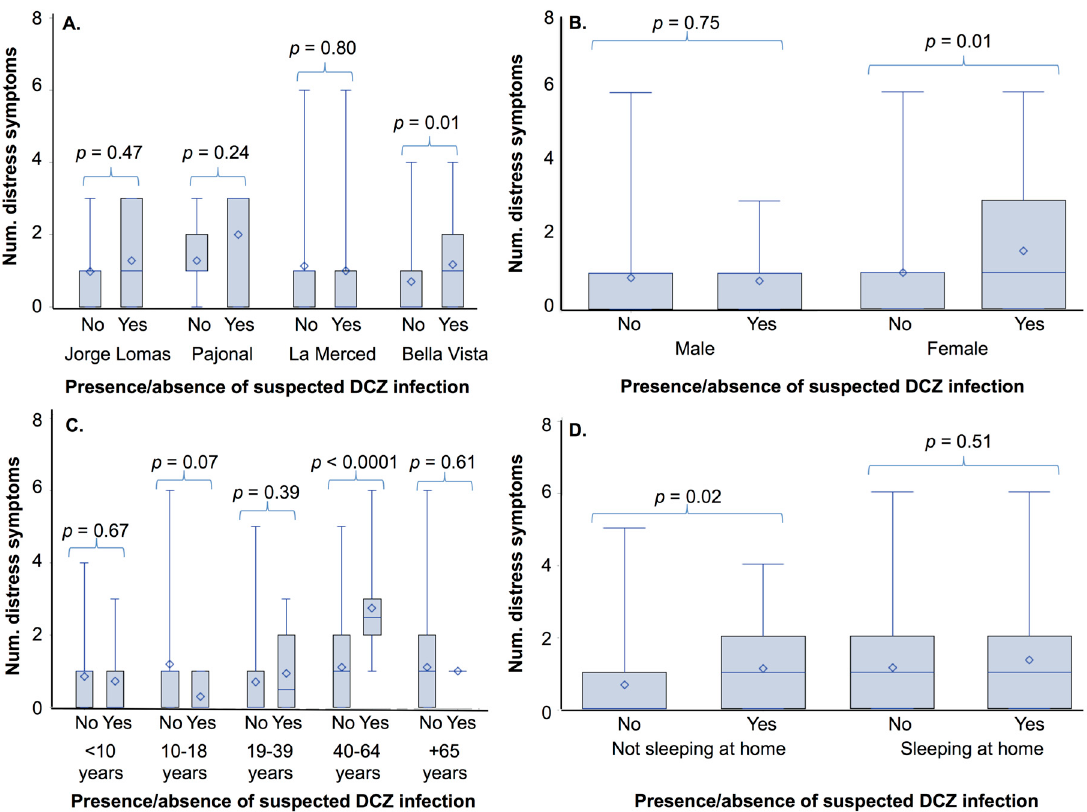
Figure 3. Average number of psychological distress symptoms among participants with and without suspected dengue, chikungunya, or Zika (DCZ) infections by ( A ) study sites, ( B ) gender, ( C ), age classes and ( D ) and whether or not the individual was sleeping at home or elsewhere. Significant differences indicated by p < 0.05.